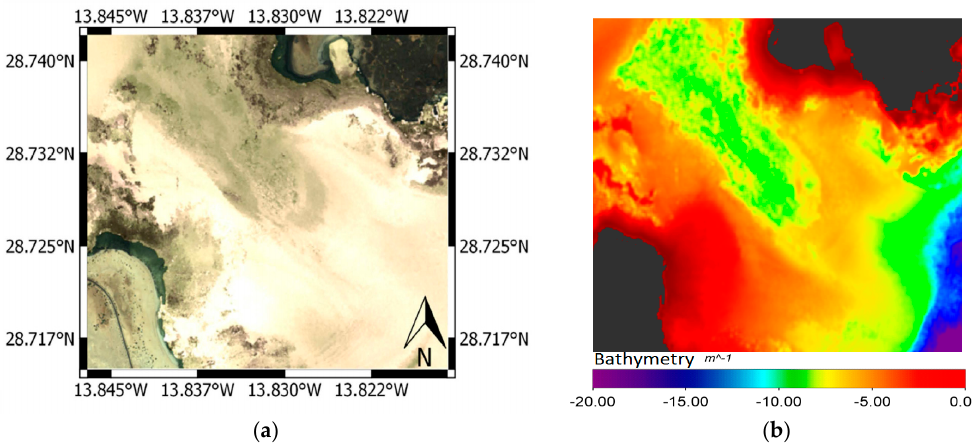
Figure 9. Results of model unmixing: ( a ) seafloor albedo (CB-G-B bands); ( b ) map of estimated depth (bathymetry). Sensors 2017 , 17 , 2639